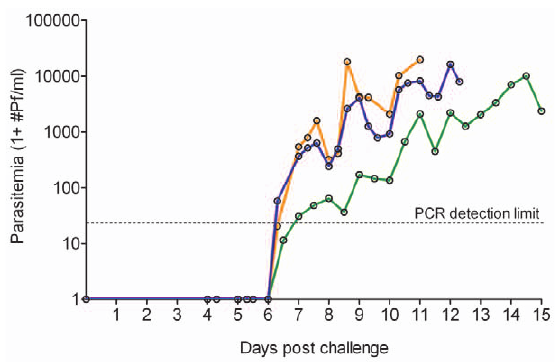
Figure 2. Geometric mean parasite density by Q-PCR per cohort. Three cohorts are depicted RUNMC I (orange), RUNMC II (blue) and Oxford